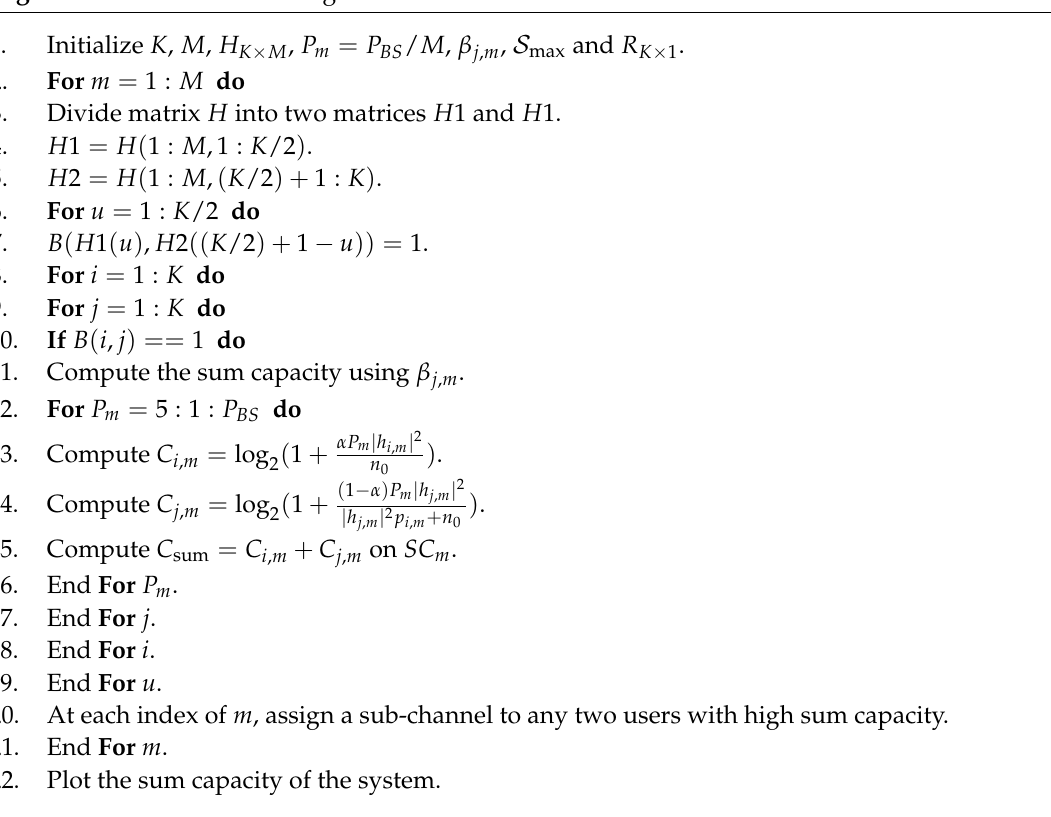
Algorithm 1 Sub-channel Assignment Based on User Channel